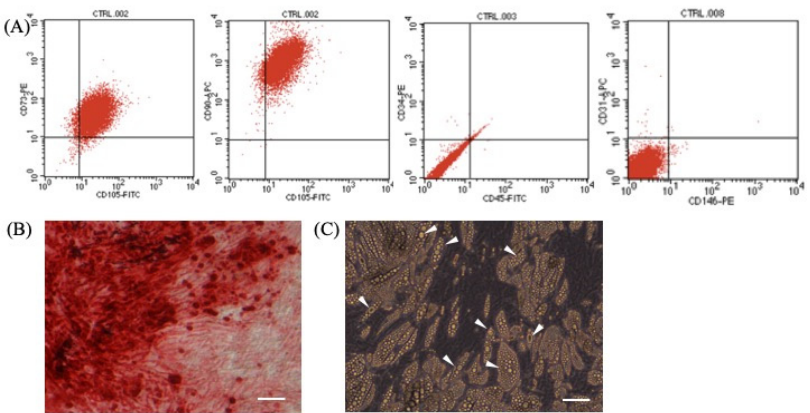
Figure 1. ( A ) Expression of surface antigen markers in isolated adipose-derived stem cells by flow cytometry. ( B ) Osteogenically differentiated ASCs’ deposits of calcium at extracellular matrix confirmed by Alizarin red. ( C ) Adipogenesis is supported by accumulation of lipid droplets (marked by white arrow). Scale bar = 50 μ m.